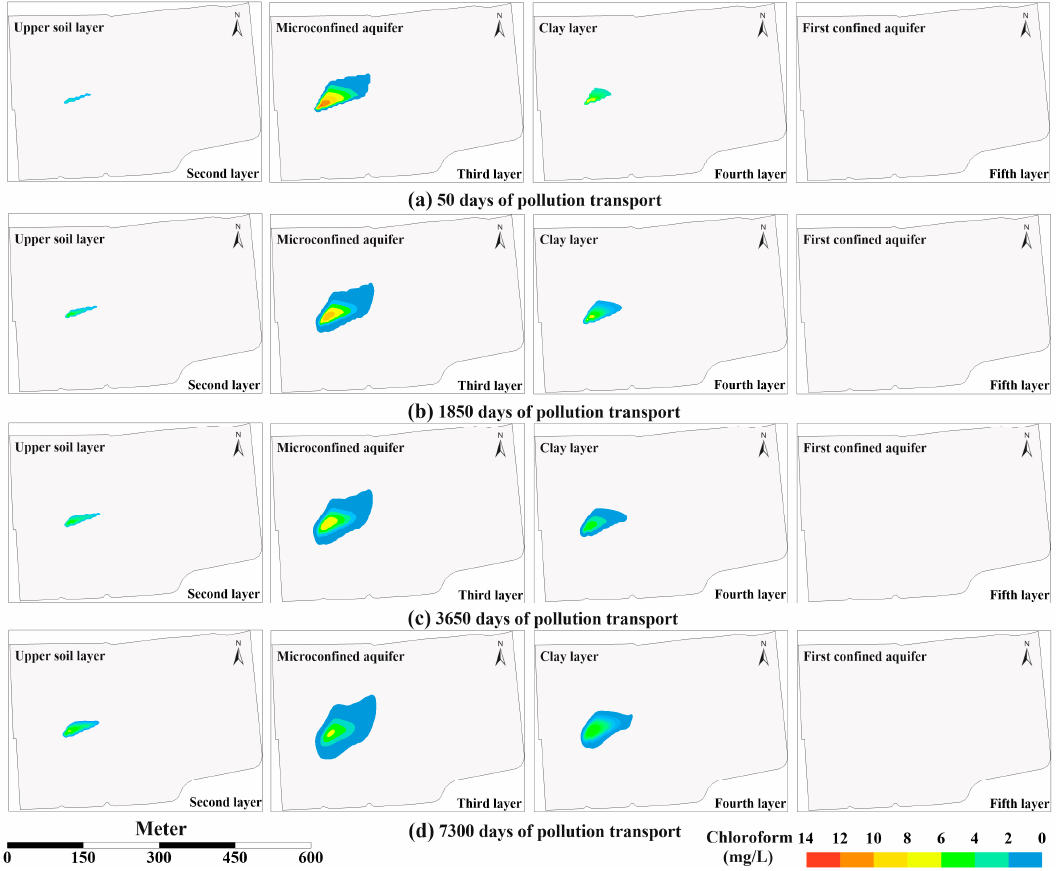
Figure 8. The adjacent soil layer of the microconfined aquifer and the transport status of contaminants in the first confined aquifer predicted over the next 20 years; ( a ) Pollutant migration for 50 days; ( b ) Pollutant migration for 1850 days; ( c ) Pollutant migration for 3650 days; ( d ) Pollutant migration for 7300